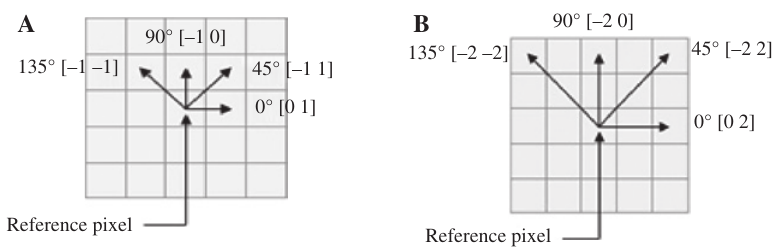
Figure 2: Directions of Co-Occurrence Matrices for Extracting Texture Features Where (A) d = 1 and (B) d =